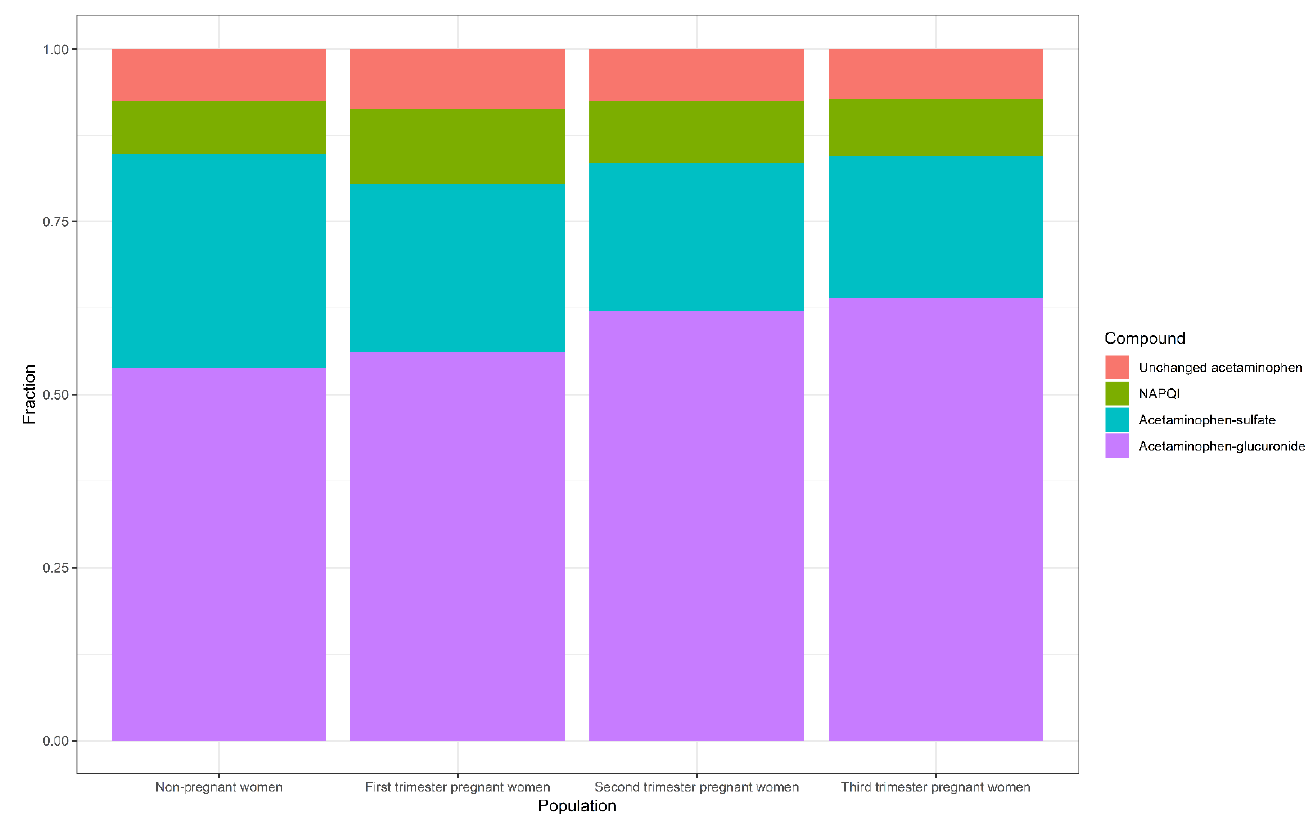
Figure 4. Barplot of the predicted molar dose fractions of unchanged acetaminophen excreted in urine and acetaminophen metabolites for non-pregnant women, and first-, second- and third- trimester pregnant women, obtained from PBPK analysis. Median fractions are shown. NAPQI = N-acetyl-p-benzoquinone imine .